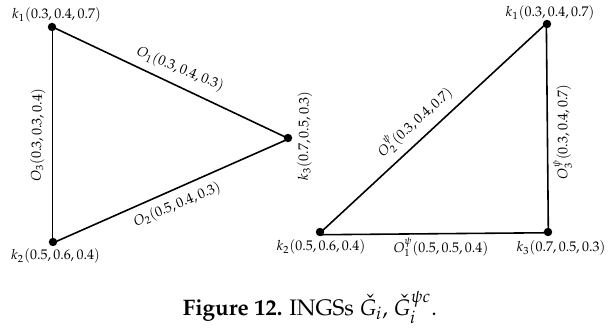
Figure 12. INGSs ˇ G i , ˇ G